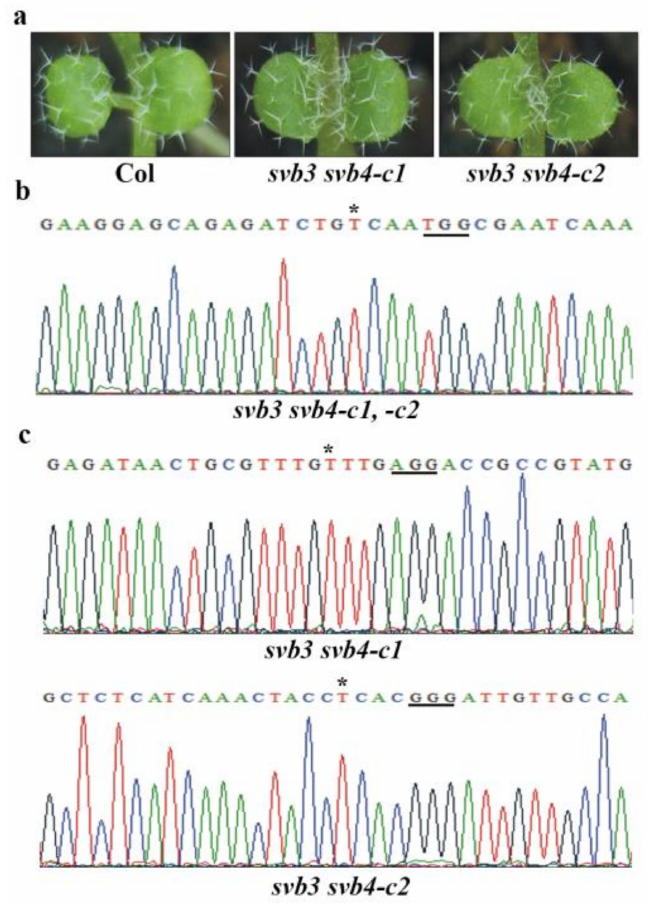
Figure 7. Mutations of SVB3 and SVB4 did not affect trichome development. ( a ) Trichome formation on the first two rosette leaves of the Col wild type and the svb3 svb4 double mutants. Seeds of the Col wild type, the svb3 svb4-c1 and svb3 svb4-c2 double mutants were sown directly into soil pots and grown in a growth room, and trichomes on the first two rosette leaves of 8-day-old seedlings were examine under a Motic K microscope and pictures were taken by using an EOS 1100D digital camera connected to the microscope. ( b ) Editing status of SVB3 in the svb3 svb4-c1 and svb3 svb4-c2 double mutants. ( c ) Editing status of SVB4 in the svb3 svb4-c1 and svb3 svb4-c2 double mutants. DNA was isolated from normal flowering T2 plants, and used for sequencing. Underlines indicate the PAM sites, and stars indicate the single nucleotide inserted in the target